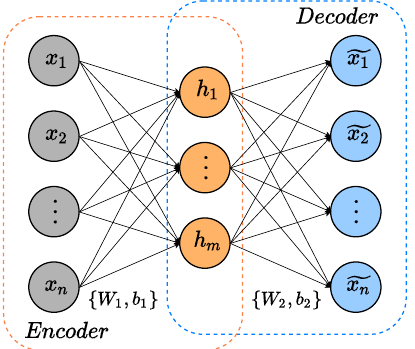
Figure 1. Basic AE